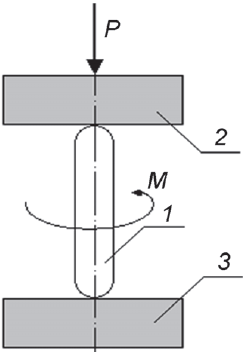
Table 1: Chemical analysis of the cast (% wt.) Elements Cu Cr Cd Zr % wt. 99.23 0.55 0.20 0.02